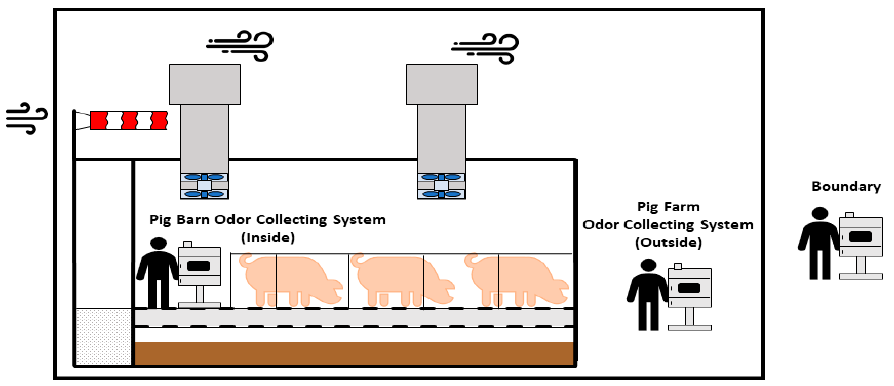
Figure 1. Odor-collecting device installed inside/outside/boundary of pig barns.